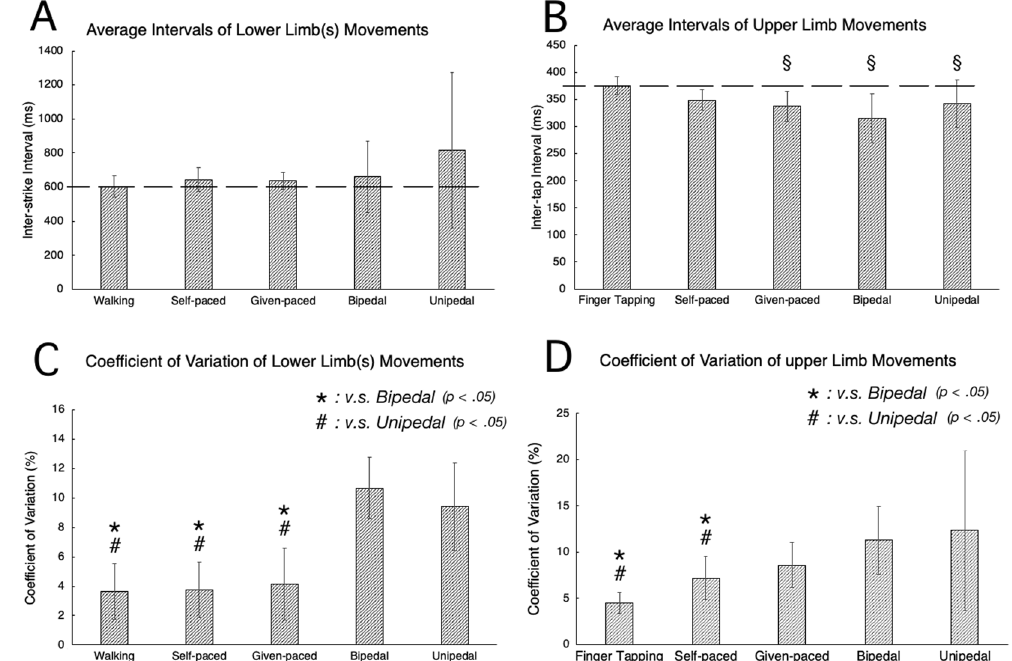
Figure 2. ( A) Average time intervals for the heel strike. The broken line indicates the target time interval, 600 ms. ( B ) Average time intervals for finger tapping. The broken line indicates the target time interval, 375 ms. ( C ) Coefficient of variation for the heel strike. ( D ) Coefficient of variation for finger tapping. Bars are s.d. § indicates a significant difference from the target interval. * and # indicate significant differences from bipedal and unipedal heel striking tasks, respectively (P <